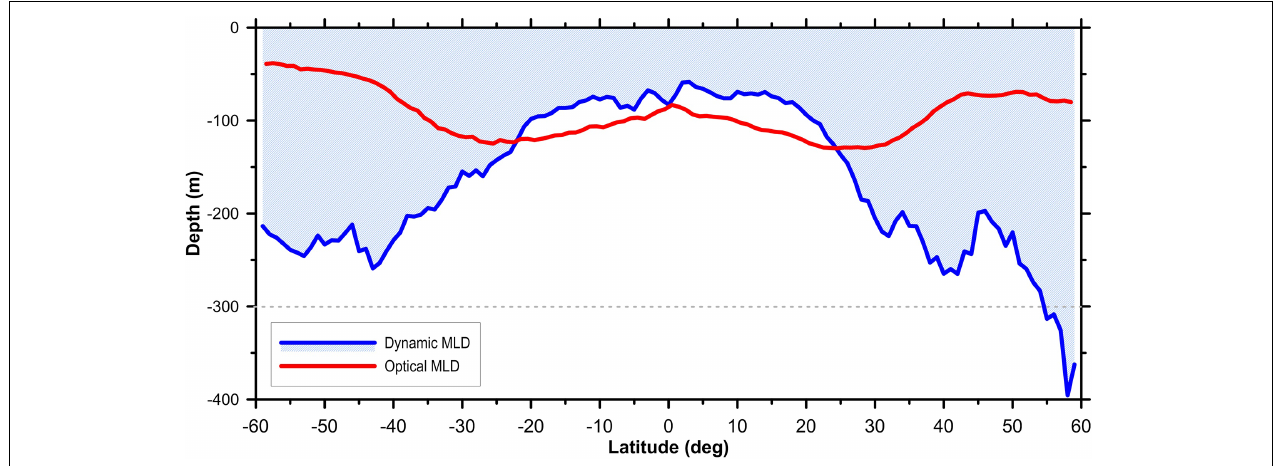
FIGURE 3 | Zonally averaged MLD for the global oceans. The red and blue lines correspond to the optically and hydrographically derived MLDs,